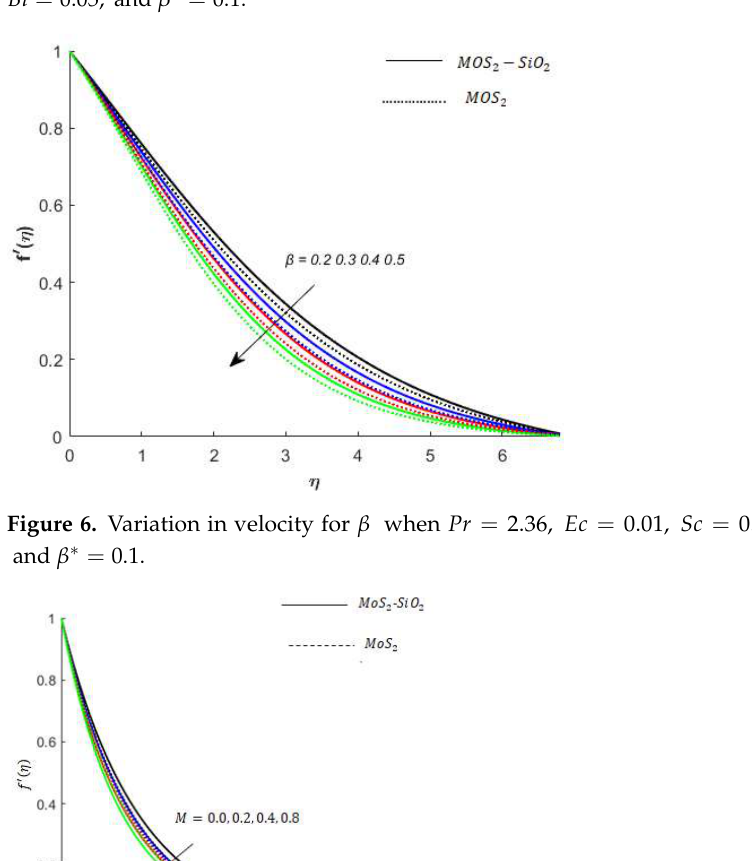
Figure 5. Variation in velocity for K when Ha 2 = 0.2, Pr = 2.36, Ec = 0.01, Sc = 0.8, Sr = 0.1, Bi = 0.05, and β ∗ = 0.1.